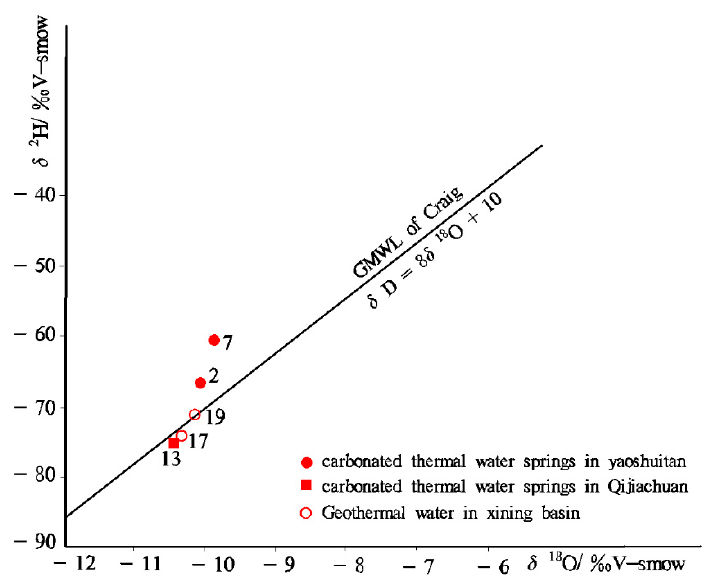
Figure 6. The relationship between δ 2 H and δ 18 O in the geothermal water of Xining Basin.